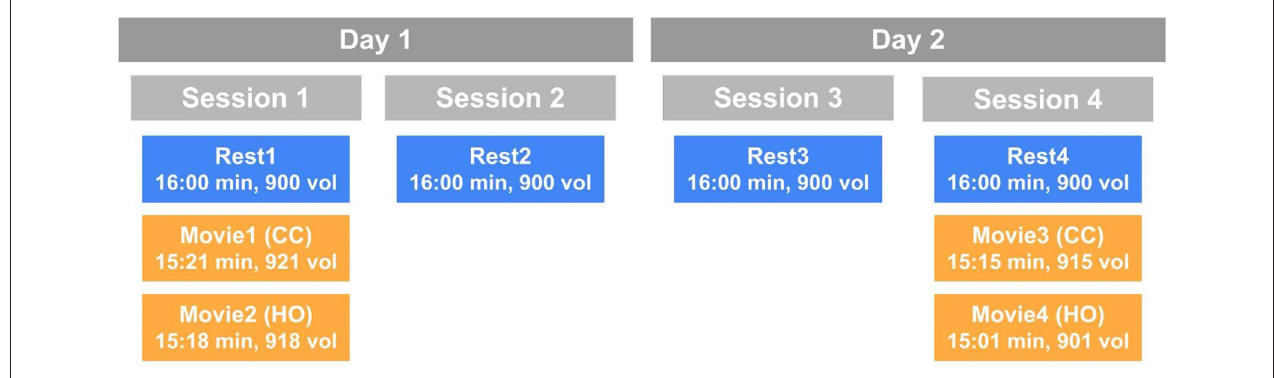
FIGURE 1 | A schematic of the HCP scanning protocol by day and session. Blue boxes indicate resting state runs and orange boxes represent movie-watching runs. CC, Creative commons; HO, Hollywood excerpts.